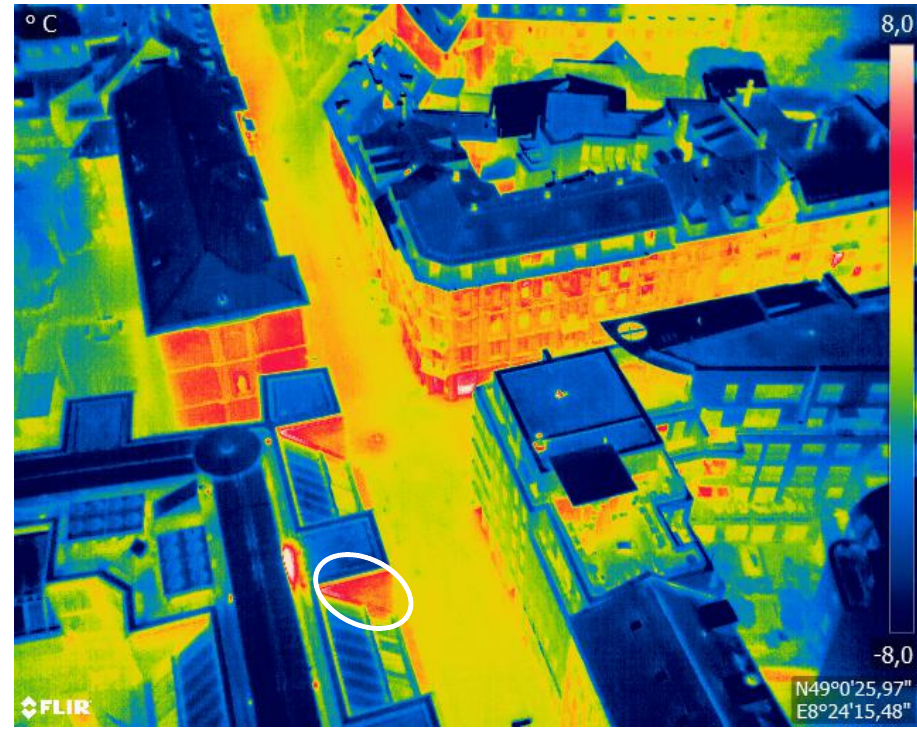
Figure A7. Example: thermal bridge of a connection between a wall and a rooftop.